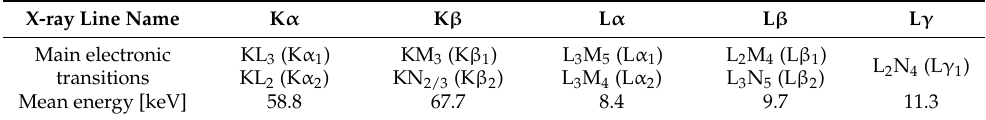
Figure 5. ( a ) Simulated energy spectra of the X-ray beam for five different source voltages from 30 kV to 225 kV at a location corresponding to the irradiated OF, with a constant current of 20 mA. The names of the main characteristic X-ray emission lines of tungsten are given next to the corresponding peaks. ( b ) Simulated fluence rate of the X-ray beam for 40 different voltages from 30 kV to 225 kV at locations corresponding to the irradiated OFs, with a constant current of 20 mA. Filled areas indicate uncertainties at ±2 σ . Table 2. Main characteristic X-ray emission lines for element tungsten (W)